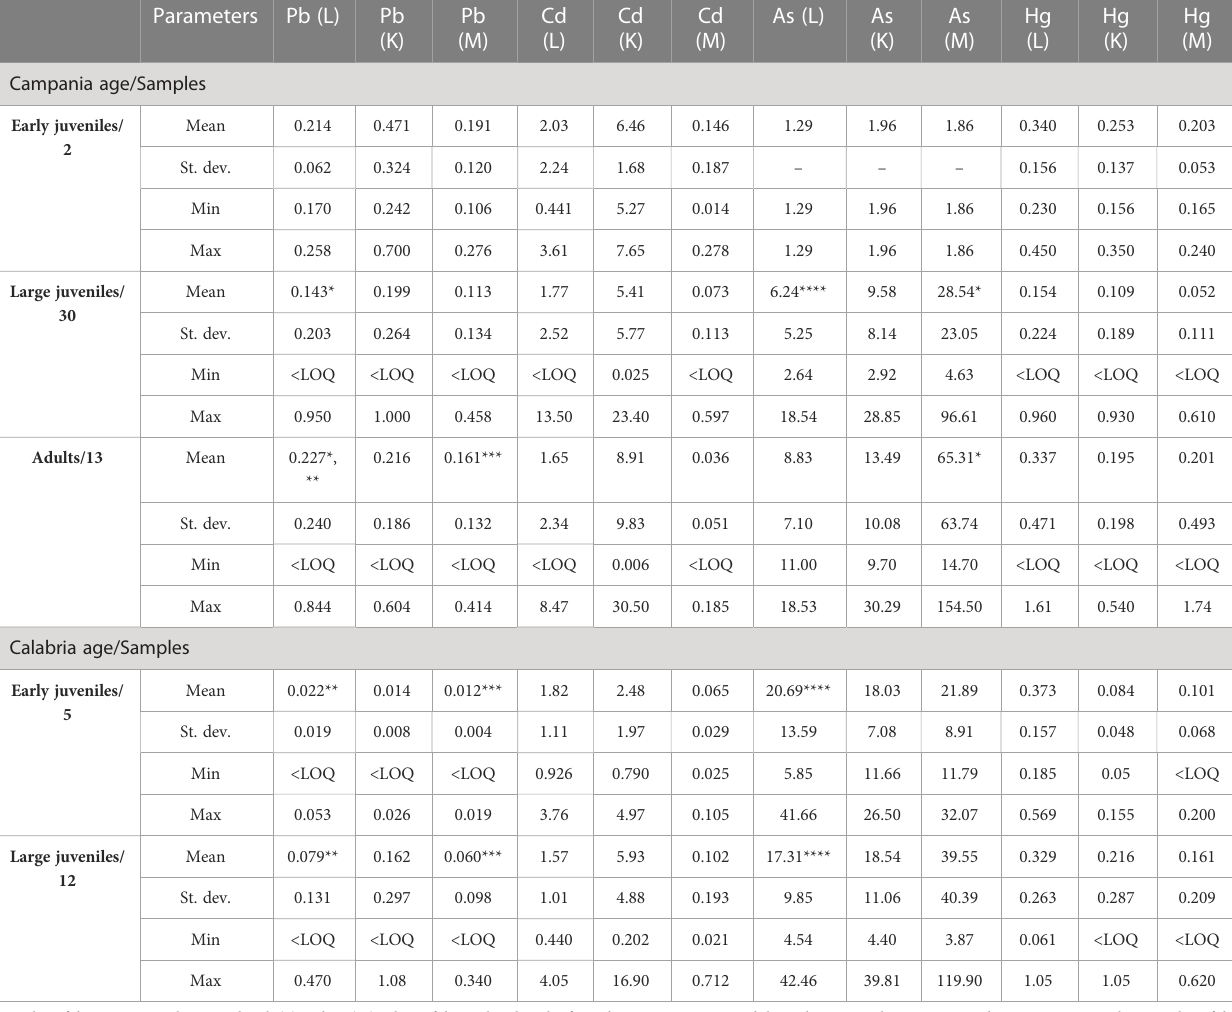
TABLE 7 Range, mean, and standard deviation of As, Cd, Hg, and Pb (mg kg − 1 wet weight) in the liver (L), kidney (K), and muscle (M) of analysed turtles according to sampling region and